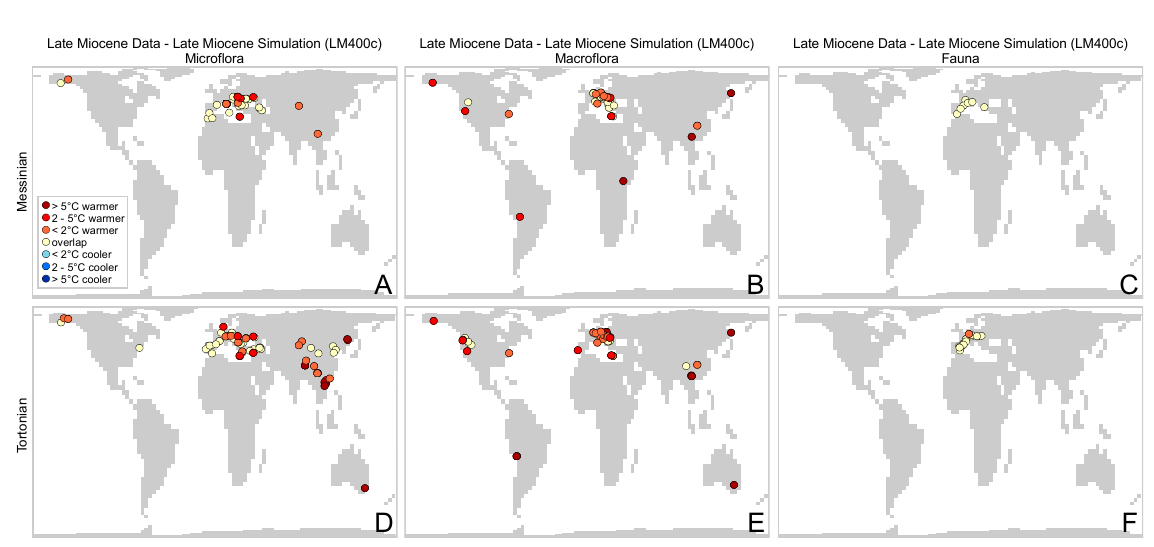
Fig. 9. Results from the model–data comparison for mean annual temperature, late Miocene